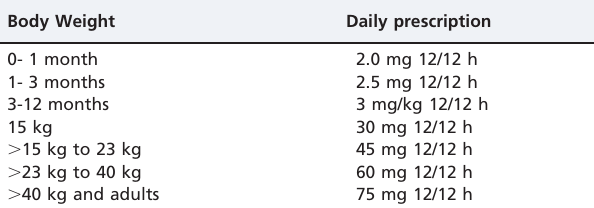
Table 2 - Manufacturer recommended dosage adopted in the pandemic